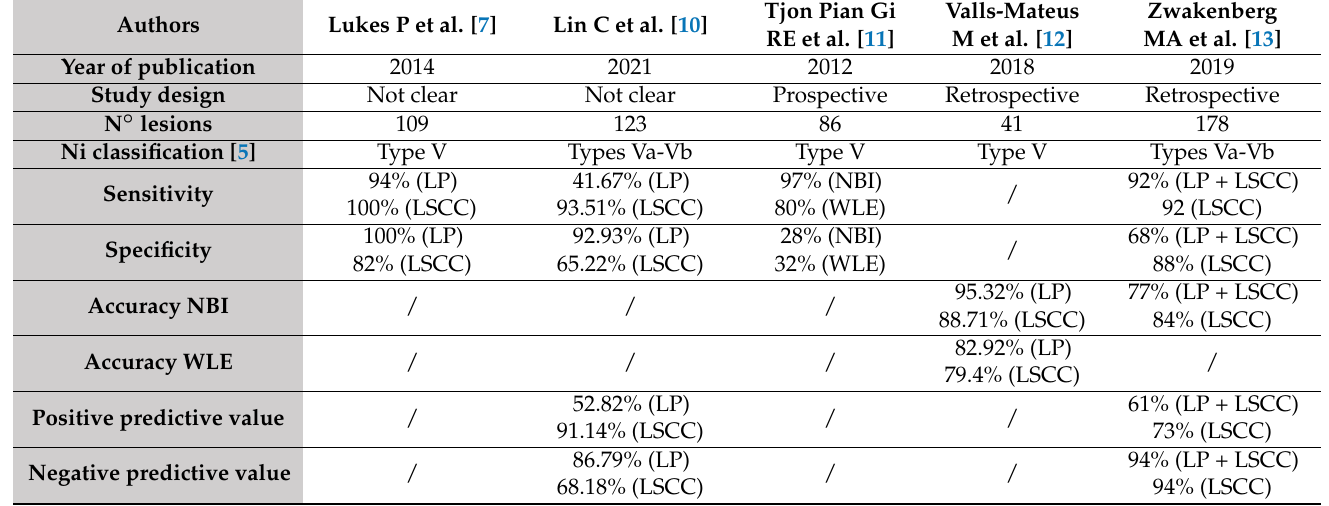
Table 2. Characteristics of the included